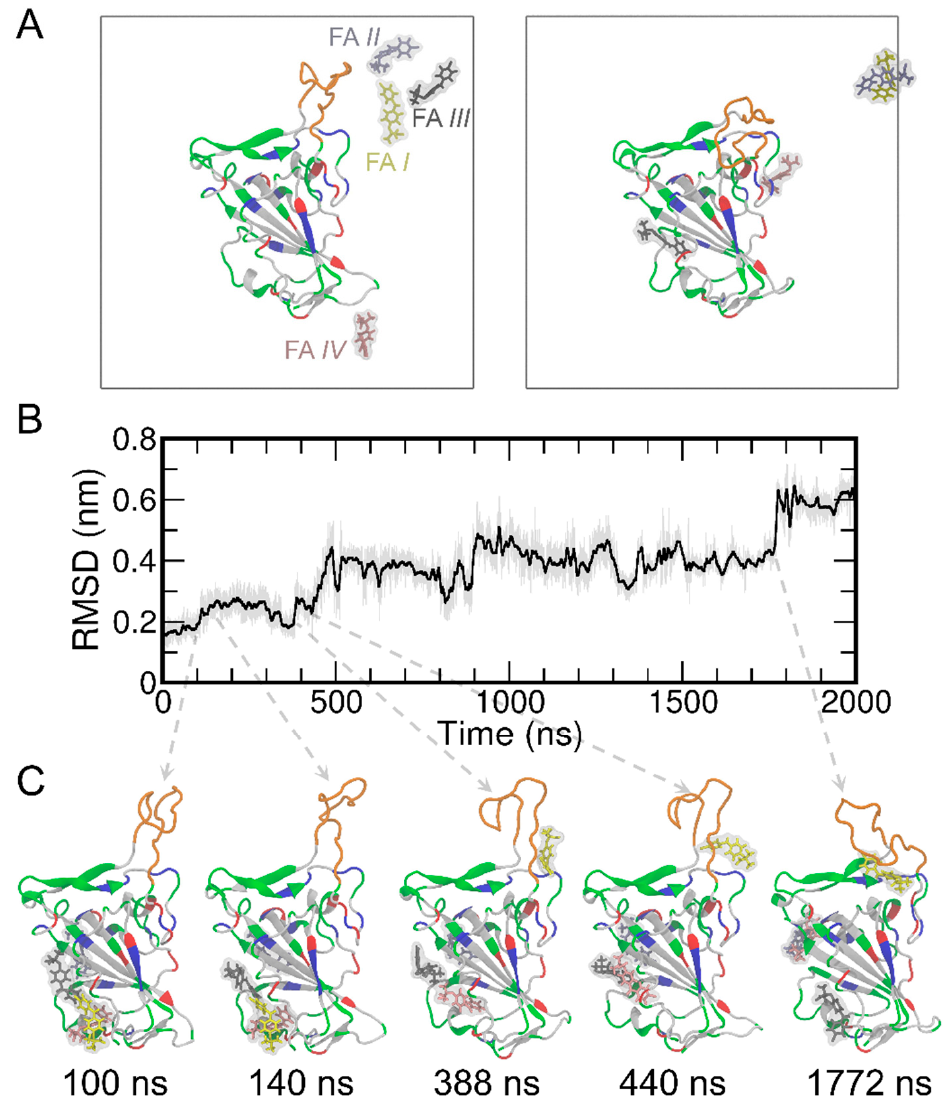
Figure 2. The initial and final structures of the MD simulations of RBD and four FA molecules ( A ) where the simulation boxes are outlined in gray. For clarity, the water molecules and ions were not displayed in the figure. The RBD protein is shown in the cartoon representation. The T470-F490 loop is shown in orange, while the rest of the protein are colored by the residue types (positively charged, negatively charged, polar, and nonpolar residues are shown in blue, red, green, and white, respectively). The FA molecules are shown in the stick representation and the surfaces are shown in transparent gray. The FA I , II , III , IV are shown in yellow, ice blue, gray, and pink, respectively. The RMSD results of the simulated RBD protein ( B ) and representative snapshots ( C ) are shown along the MD simulations.